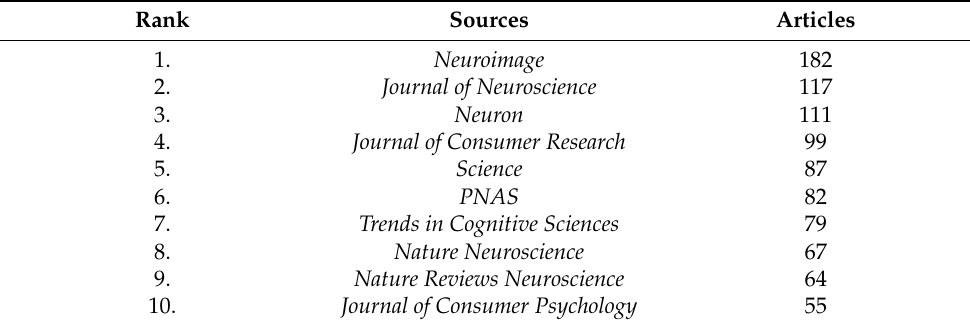
Table 5. Top 10 Most Local Cited Sources (from Reference Lists).